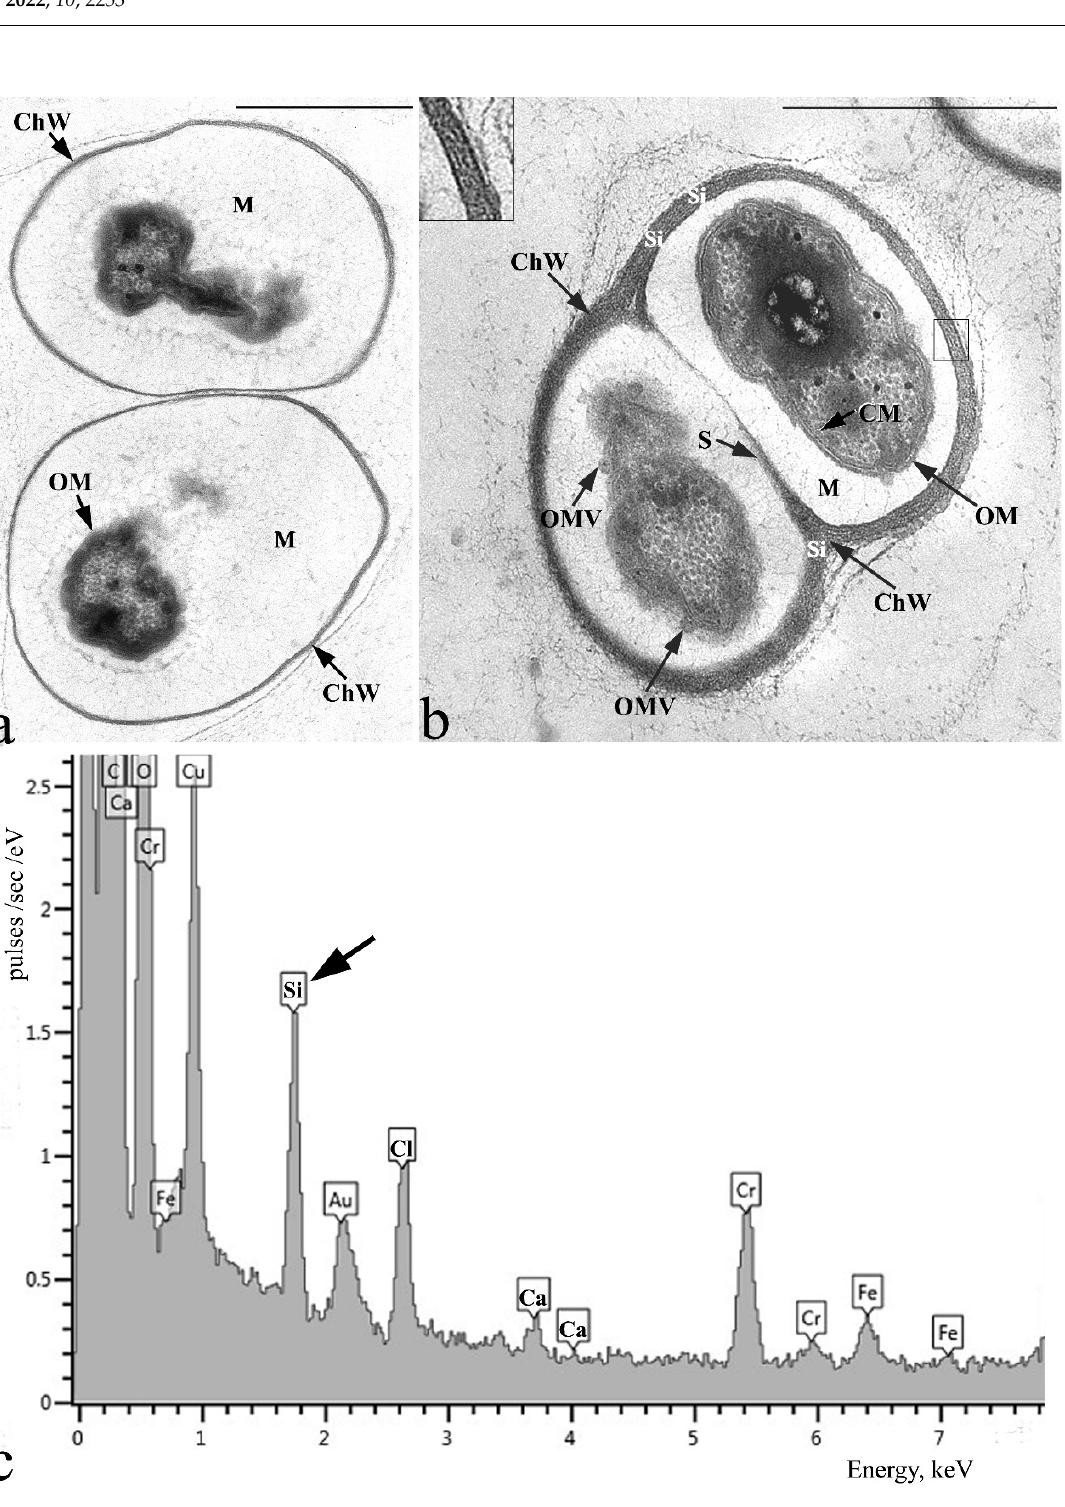
Figure 3. Electron micrograph of the ultrathin sections of 2-week-old ( a ) and 30-day-old ( b ) cells of Acidisarcina polymorpha SBC82 T grown in the liquid medium MA and X-ray spectrum of chamber wall from 30-days old cell aggregate ( c ). The insert in the upper left corner of ( b ) shows an enlarged fragment of the chamber wall indicated by the box in this figure. ChW—chamber wall; OM—outer membrane; CM—cytoplasmic membrane; S—septum; M—chamber matrix; OMV—outer membrane vesicles; Si—silicon (pointed by arrow in ( c ). Bars ( a , b ), 1 µ